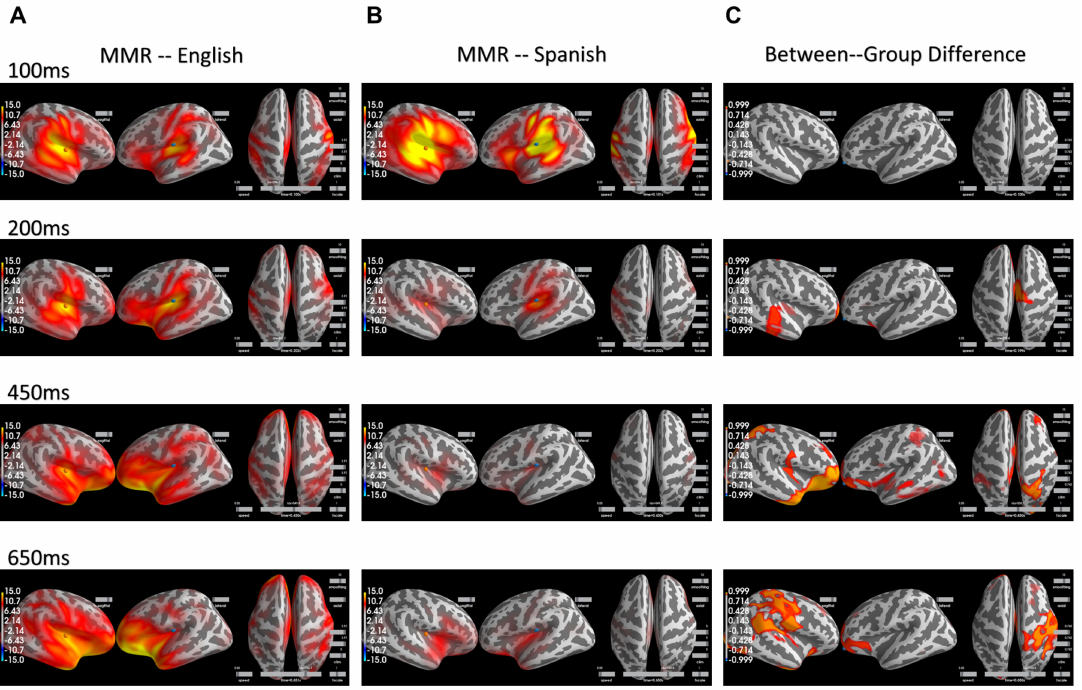
Figure 2. ( A ) MMR across the whole brain over time for the Monolingual English speakers. ( B ) MMR across the whole brain over time for the Native Spanish speakers. ( C ) The spatial regions that are significantly different between the two groups over time. They largely occur after 200 ms and are predominantly in the right